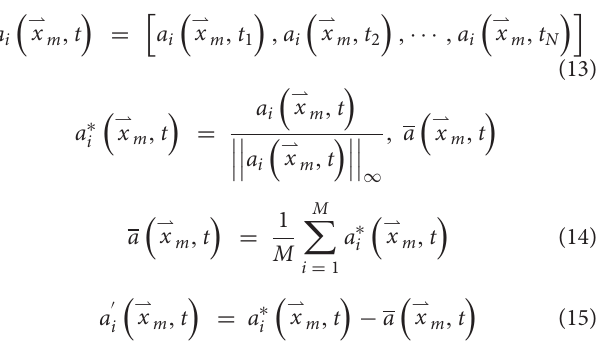
Frontiers in Physiology |